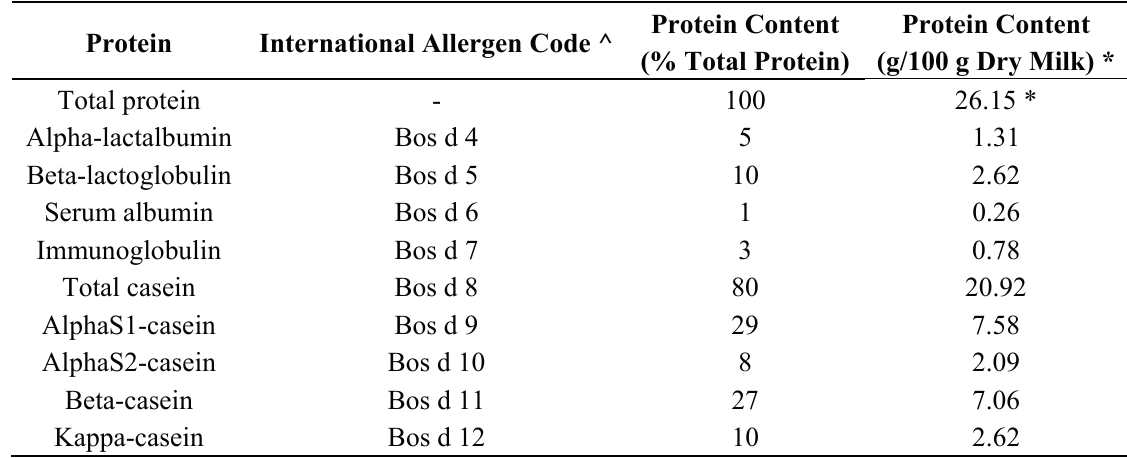
Table 3 . Main allergens of cow’s